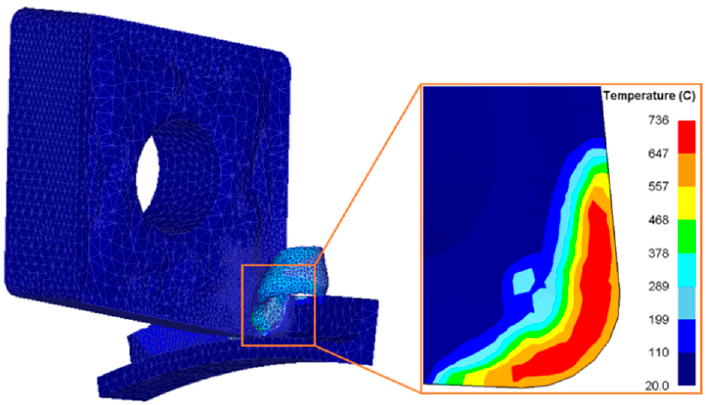
Figure 2. Simulation result showing surface temperature of Tool 1 in stable temperature situation.